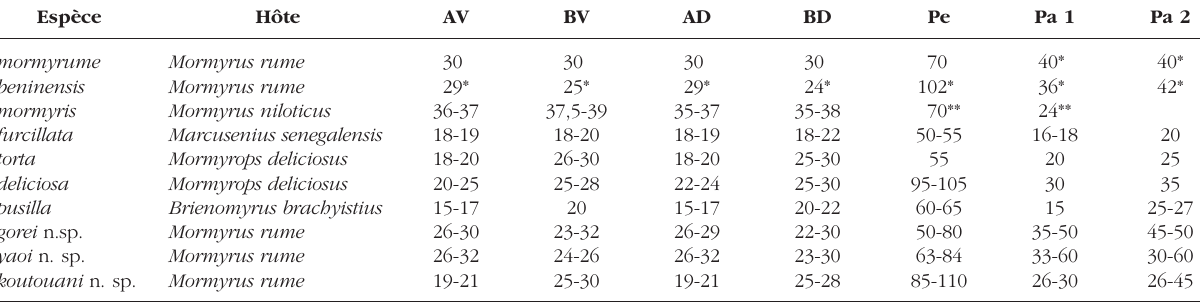
B OUIXELLA YAOI N . SP . (figure 3) Hôte type : Mormyrus rume Valenciennes, 1846.